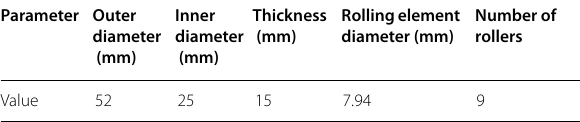
Table 1 Parameters of 6205-2RS JEM SKF Parameter Outer diameter